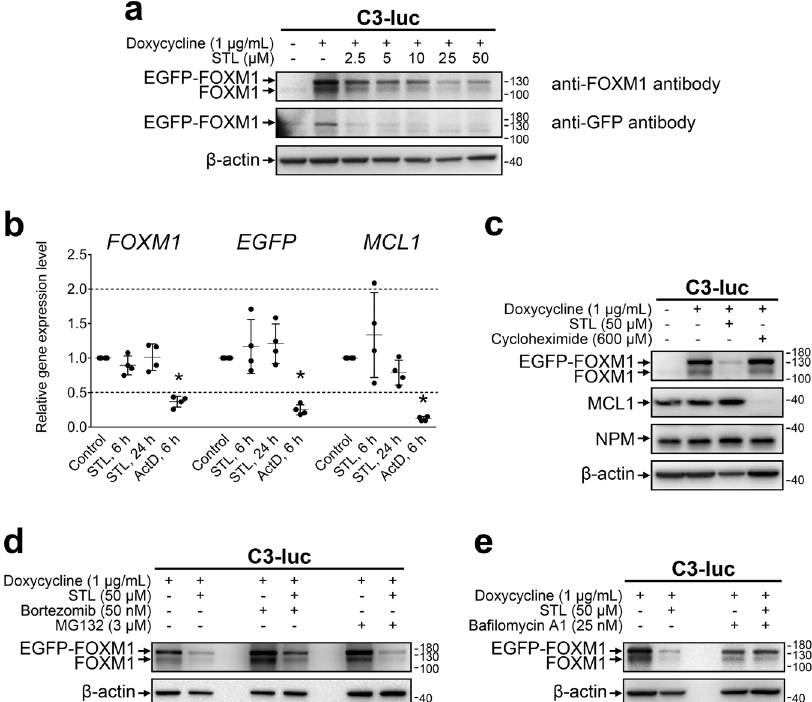
Fig. 2 STL inhibits FOXM1 expression on protein level via autophagy-dependent mechanism. a C3-luc cells stimulated with doxycycline to induce expression of EGFP-FOXM1 fusion protein were treated with increasing concentrations of STL for 24 h. Total protein samples were analyzed via immunoblotting for FOXM1 and GFP expression, β -actin was used as an internal loading control. b Doxycycline-stimulated C3-luc cells were treated with 50 μ M STL for 6 or 24 h and 10 μ g/mL ActD for 6 h. Total RNA samples were analyzed for FOXM1 , GFP , and MCL1 transcript levels via RT-qPCR, 18 S rRNA was used as a reference transcript. Data are presented as means ± S.D. and individual datapoints, N = 4, * – exact p = 0.02857 (Mann – Whitney U test, two-tailed). c C3-luc cells were treated with indicated concentrations of doxycycline, STL, or CHX for 24 h. Total protein samples were analyzed via immunoblotting for FOXM1, NPM, and MCL1 expression, β -actin was used as an internal loading control. d Doxycycline-stimulated C3-luc cells were treated with STL for 24 h in the presence of bortezomib or MG132. Total protein samples were analyzed via immunoblotting for FOXM1 expression, β -actin was used as an internal loading control. e Doxycycline-stimulated C3-luc cells were treated with STL for 24 h in the presence of ba fi lomycin A1. Total protein samples were analyzed via immunoblotting for FOXM1 expression, β -actin was used as an internal loading